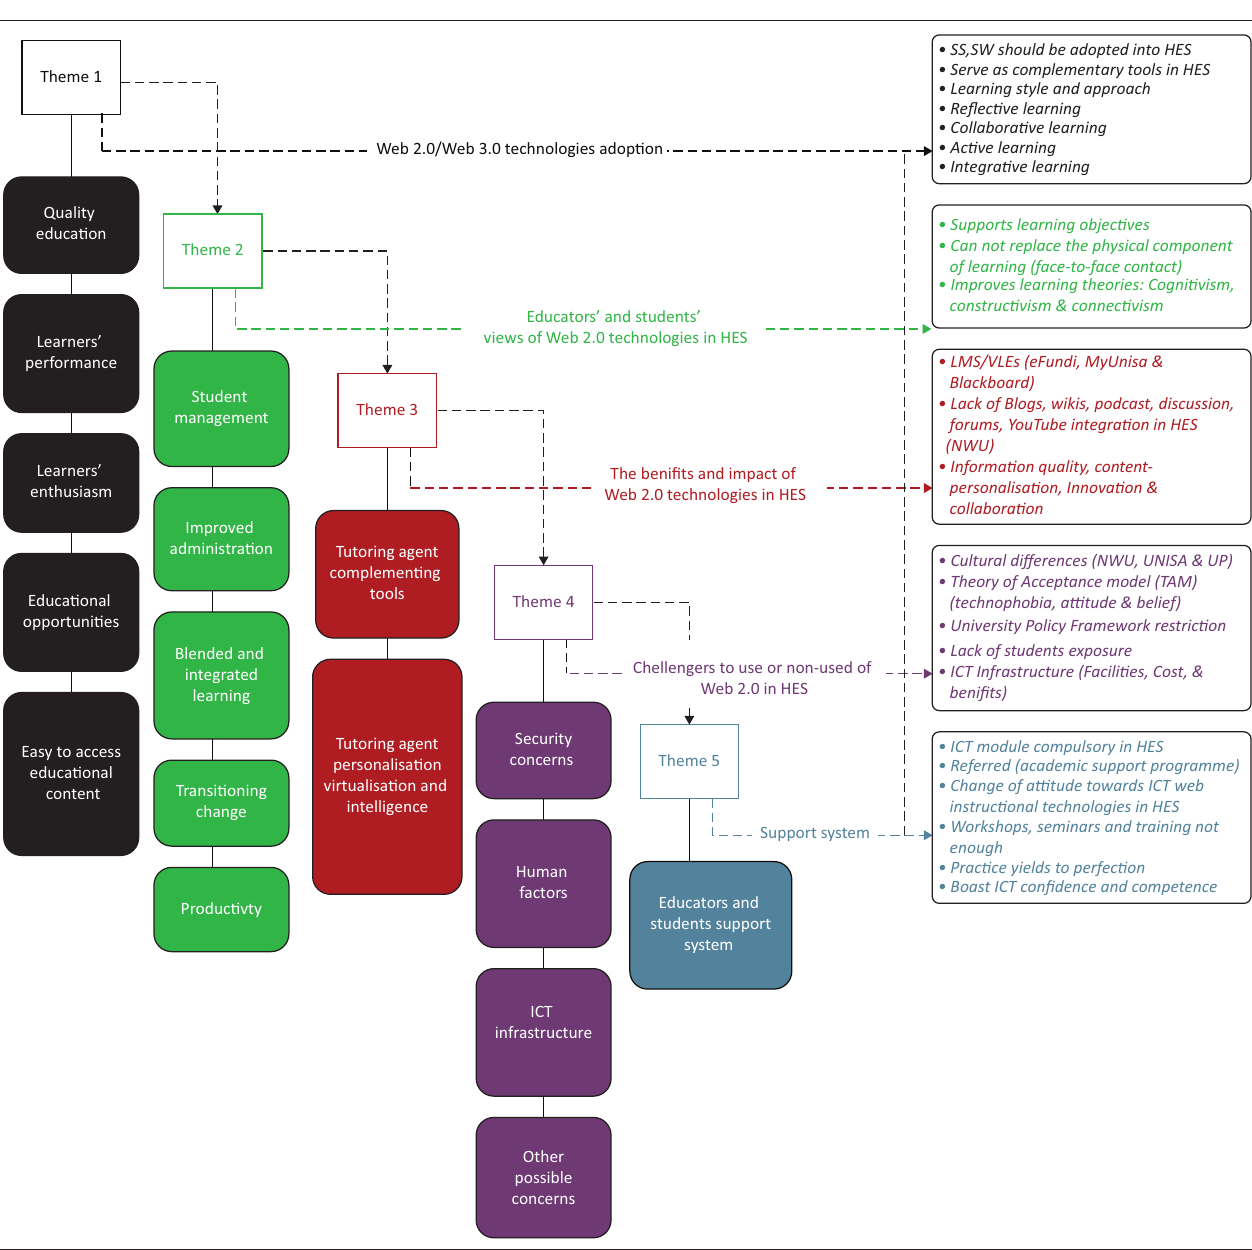
FIGURE 5: Framework for Web 2.0 and Web 3.0 adoption in higher education